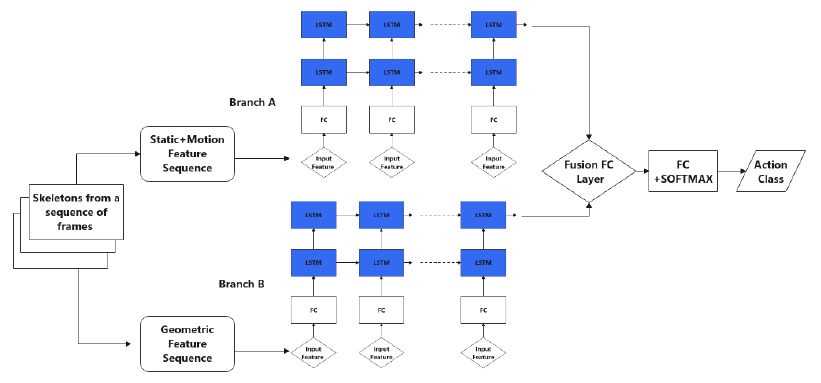
Figure 6. Mid-fusion network